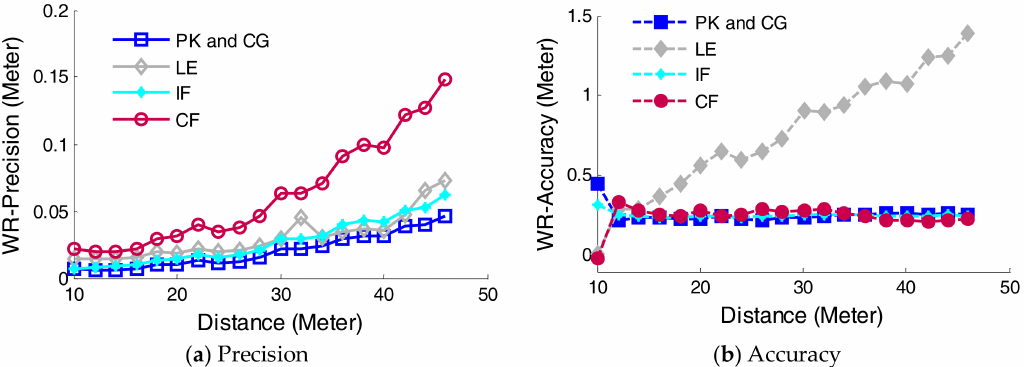
Figure 9. Precision and accuracy comparison of five time discrimination algorithms. PK, CG, LE, IF, and CF stand for peak, center of gravity, leading edge, inflection, and constant